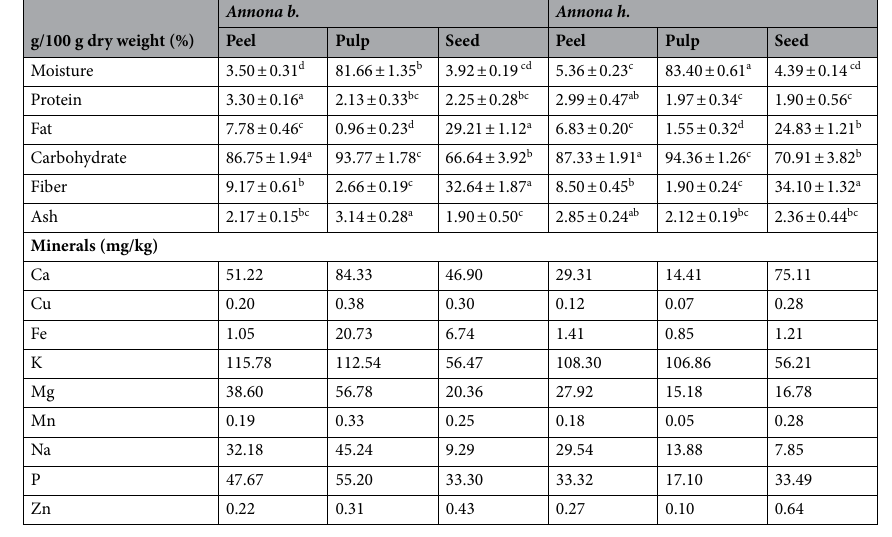
Table 1. Proximate chemical composition of different parts for Annona b. and Annona h. Means ± SD (standard deviations) in the same row followed by the same letters are not significantly different ( P < 0.05). Each data point is the average of three